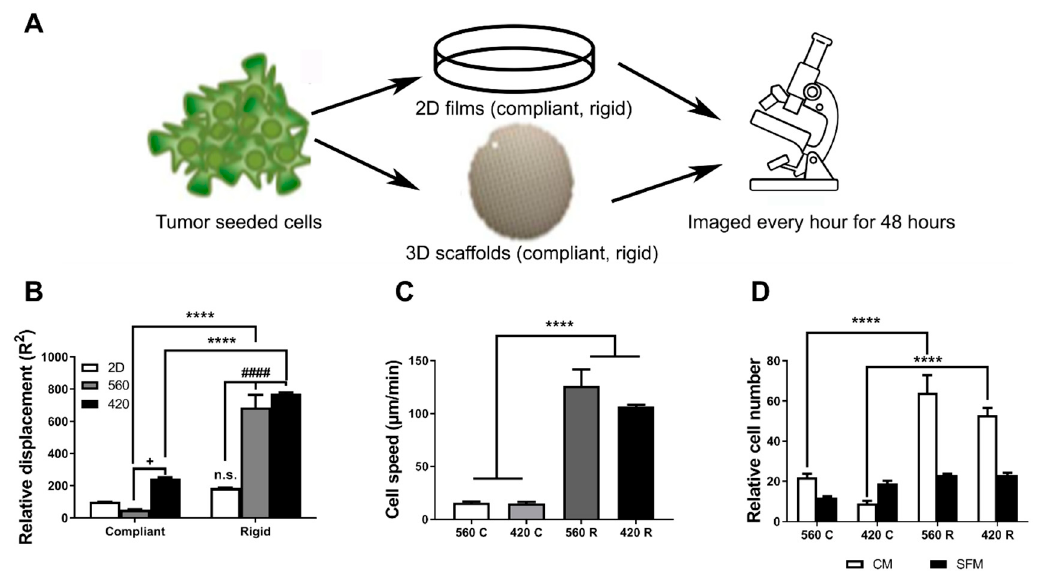
Figure 2. Rigidity and pore size affect migration of tumor cells on 3D scaffolds. ( A ) Schematic of experimental procedure ( B ) Live cell imaging using bright field microscopy demonstrates significantly higher cell motility on 560R (>6-fold) and 420R (>7-fold) scaffolds as compared to compliant films (2D Compliant, white column). ( C ) Motility assay using confocal imaging shows that tumor cells have significantly increased speed on the 560R (>8-fold) and 420R (>7-fold) scaffolds compared to compliant scaffolds. ( D ) 3D migration transwell assay with either 10% FBS media (CM) or serum-free medium (SFM) determined tumor cells have higher migratory potential on 560R (3-fold) and 420R (>2.5-fold) 3D scaffolds as compared to 560C and 420C scaffolds. 2way ANOVA. Compliant vs Rigid, **** p < 0.0001. 2D vs 3D, #### p < 0.0001. 560 vs 420, + p < 0.05.